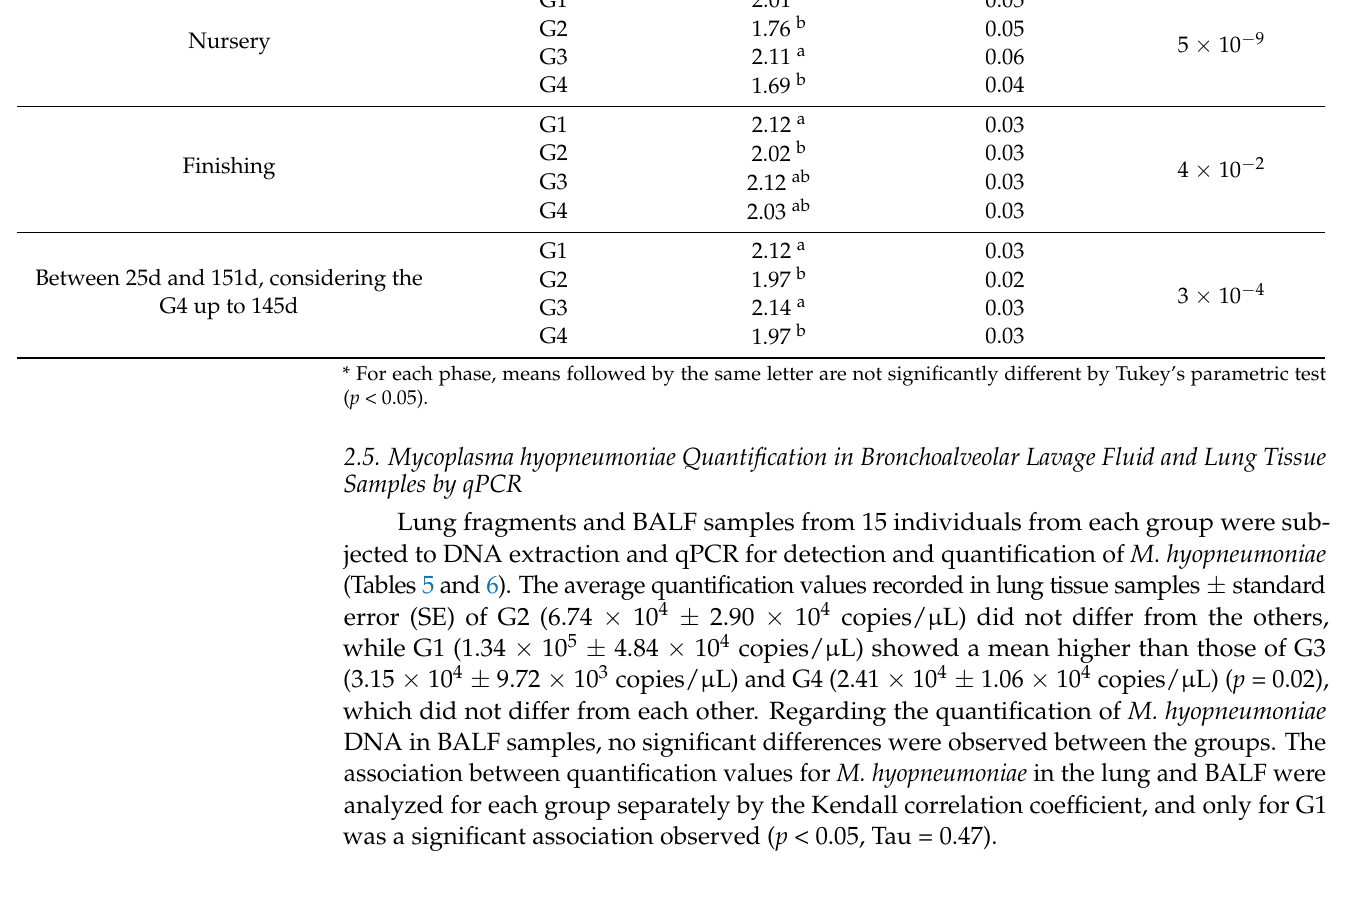
Table 4. Feed conversion of the four groups in the nursery, finishing, and weaning to slaughter phases. Food Conversion (FC) (kg) Group Mean * Standard